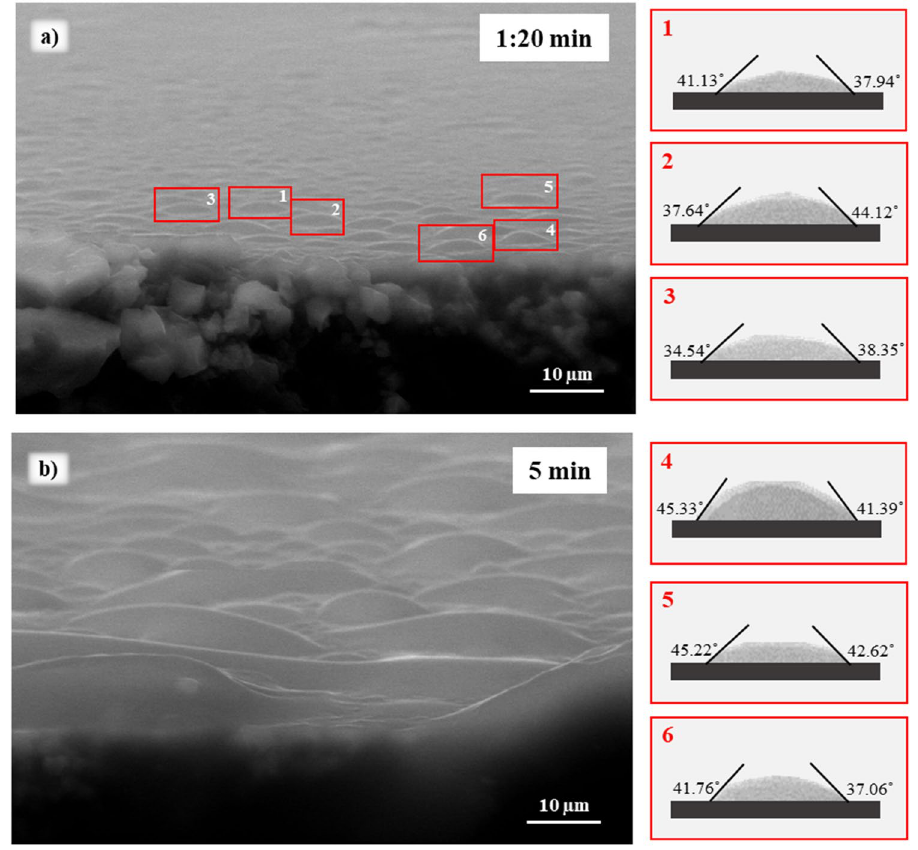
Figure 2. Water condensation experiments performed on calcite sample (before aging in acids) by ESEM at different times ( a ) 1:20 min and ( b ) 5 min. The chamber temperature and pressure were held at 0 °C and 899